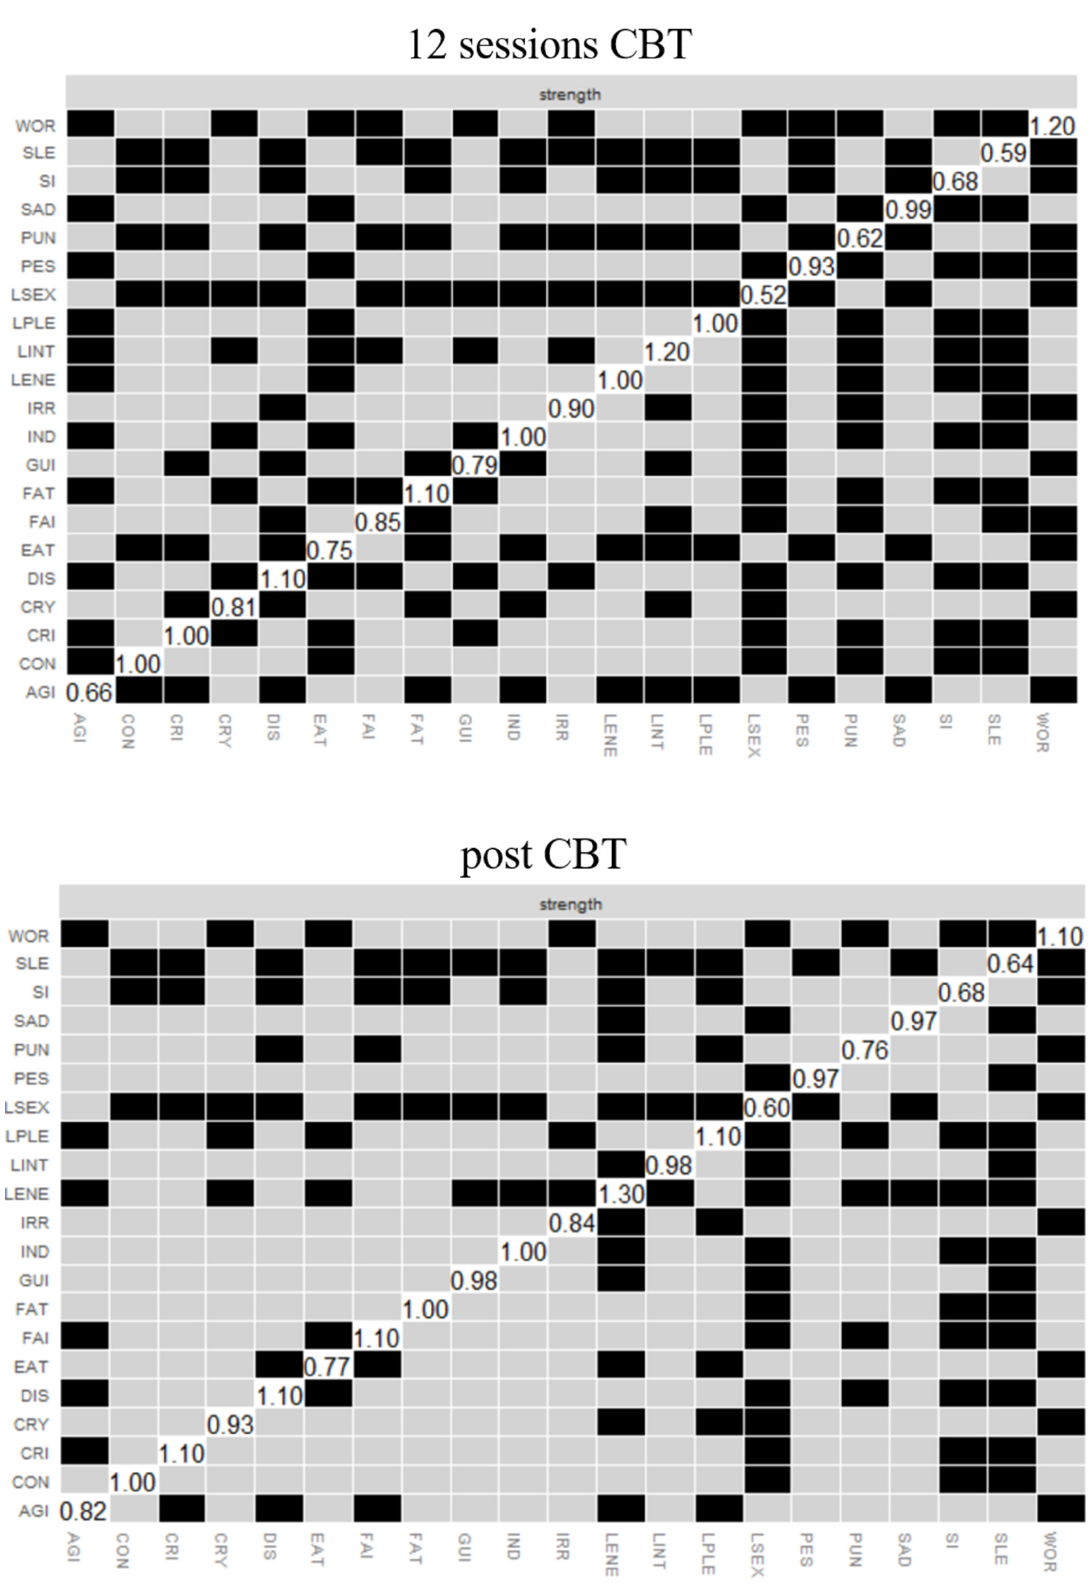
Figure 2. Bootstrapped difference tests of strength between nodes for the pre-CBT network, the network after 12 sessions of CBT, and the post-CBT network ( n = 401). Note. Black boxes indicate nodes that differ significantly from one another, while gray boxes indicate nodes that did not differ significantly from one another. White boxes show the value of strength centrality for a given node.